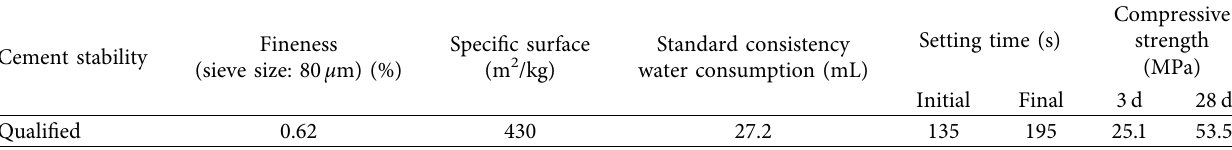
Table 1: Basic properties of cement.